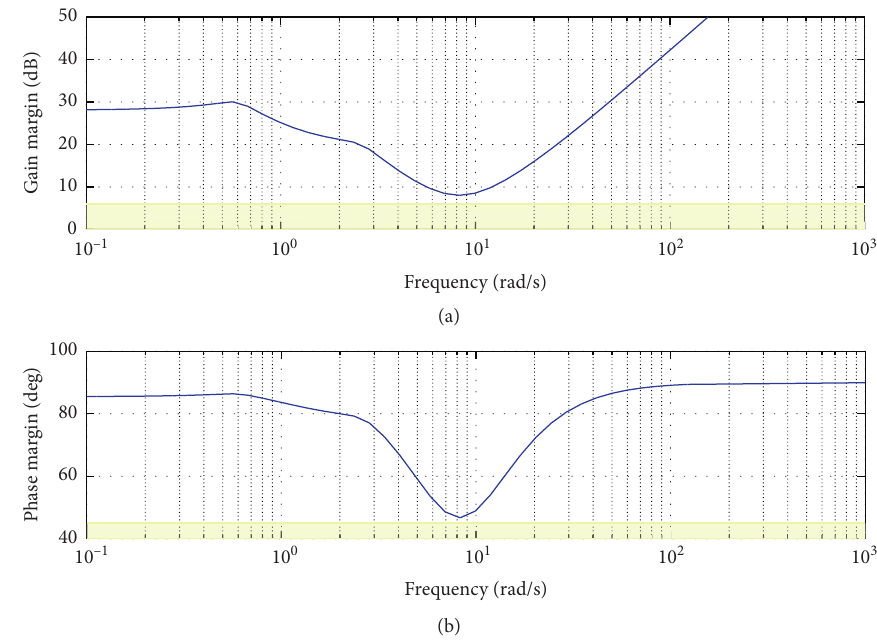
Figure 14: The robust stability margin with the basic